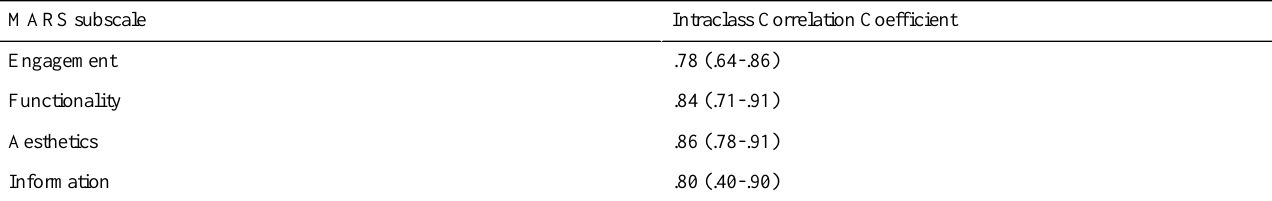
Table 1. Interrater reliability of the MARS subscales (95% CI).